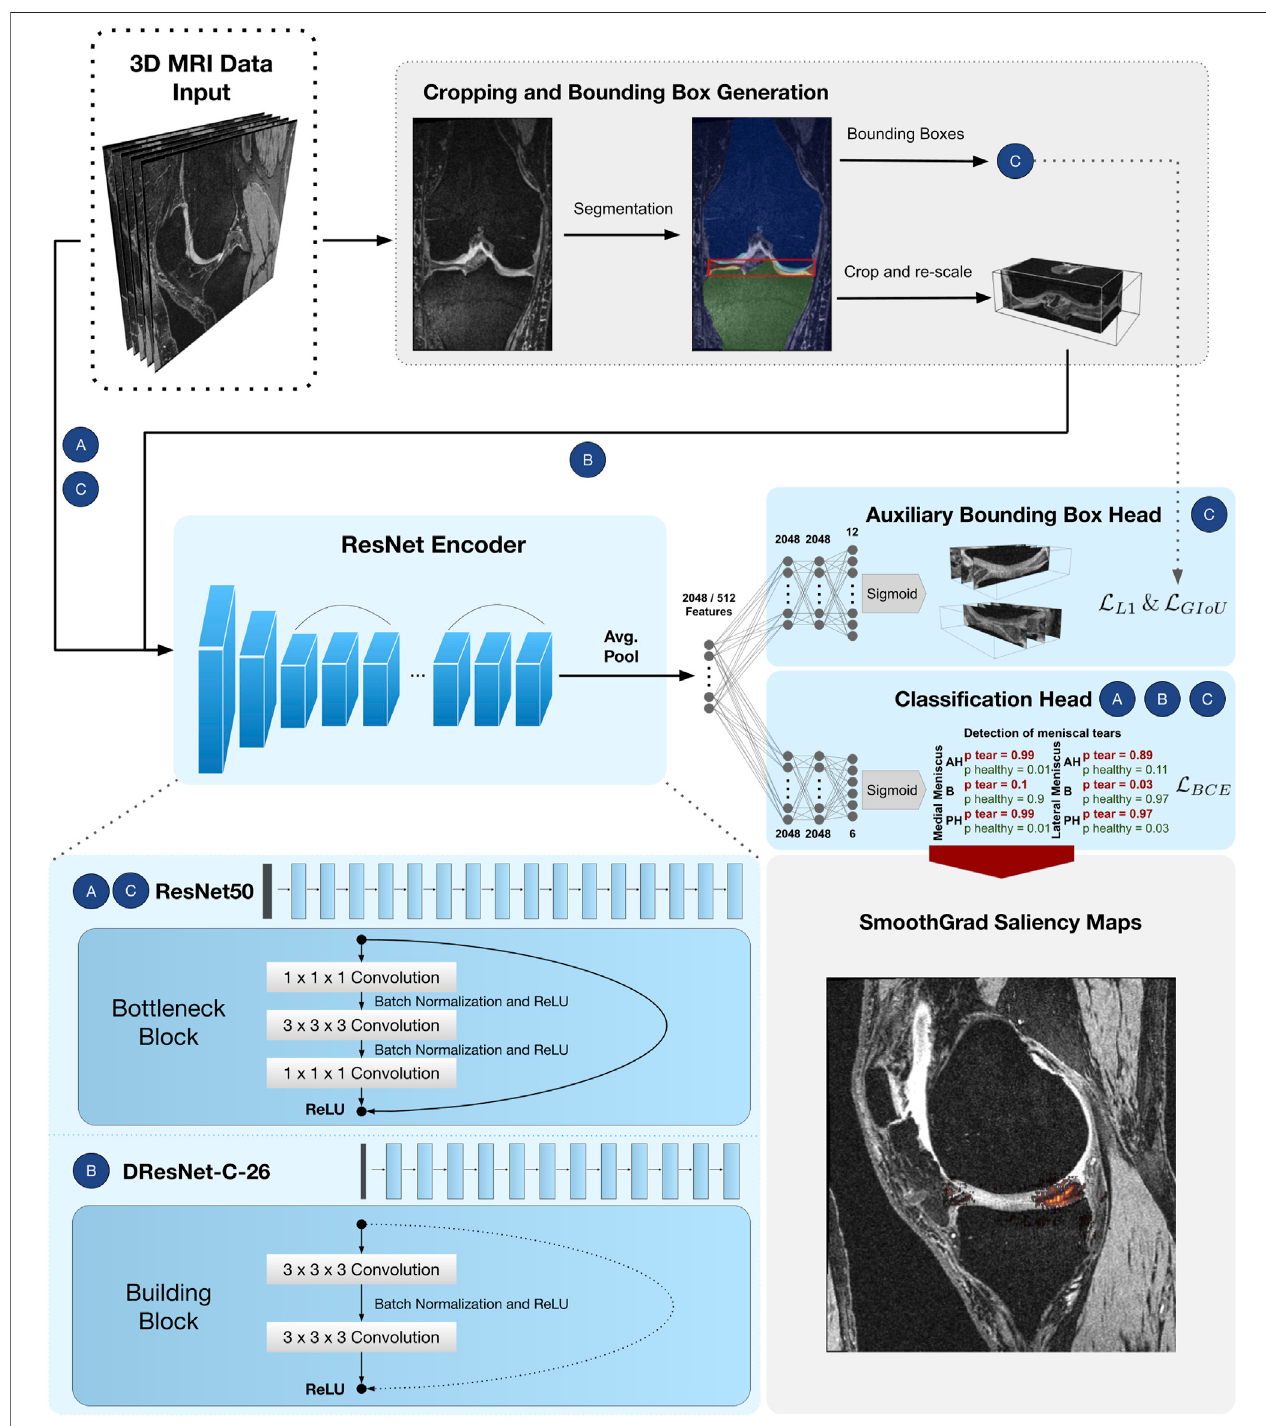
FIGURE 2 | CNN pipeline for detection of meniscal tears in six sub-regions. Approach Full-scale uses a ResNet50 encoder followed by a classi fi er head with L BCE for classi fi cation of meniscal tears in 3D MRI data (A) . Approach BB-crop reduces the 3D MRI input to the meniscal RoI and uses a DRN-C-26 encoder followed by a classi fi er head with L BCE to detect meniscal tears (B) . Approach BB-loss uses a ResNet50 encoder followed by a classi fi er head with L BCE as well as another bounding box regression head with L L 1 and L GIoU in order to predict bounding boxes of the menisci in the 3D MRI data (C) . The ResNet50 is made up of an initial convolutional layer followed by max-pooling before 16 ResNet bottleneck blocks with residual connections are stacked. The DRN-C-26 starts with the same convolutional layer but is immediately followed by ten residual building blocks and, lastly, two building blocks without a residual connection. After average pooling, the encoders generate 2048 and 512 features, respectively. Finally, SmoothGrad saliency maps are presented as overlaid heatmaps on top of the respective MR image to highlight these regions that mostly in fl uenced the detection of tears (bottom right